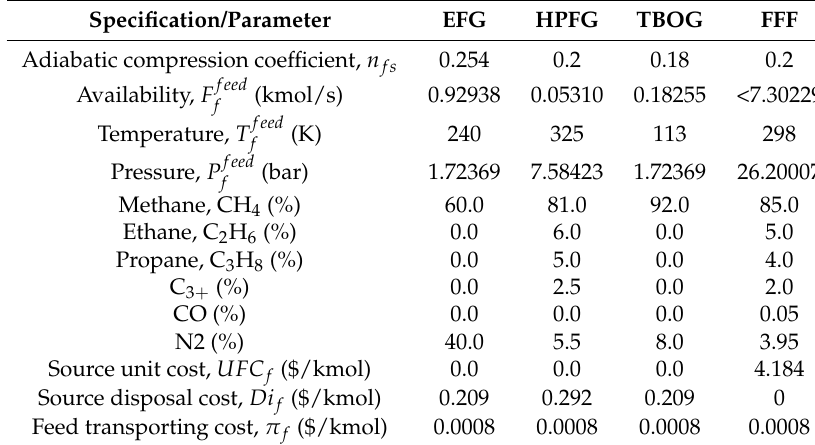
Table 1. Sources streams specifications.